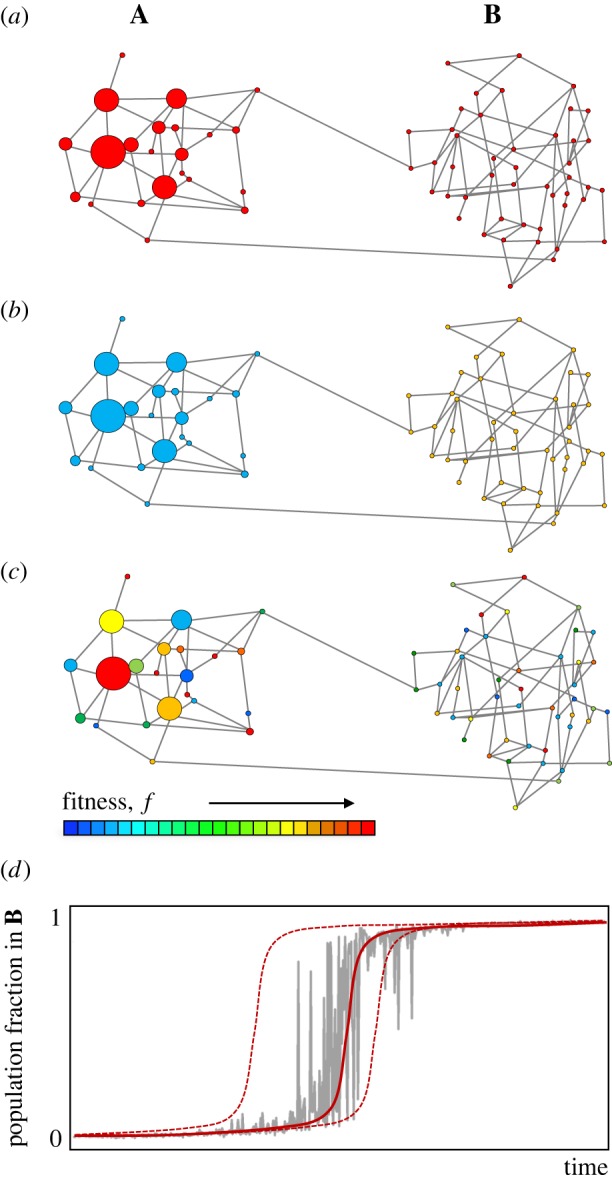
Genomic shifts result from the network-of-networks structure of the space of genotypes. Without loss of generality, we assume that λ1,A < λ1,B and the whole population is initially in network A. In (a–c), colours indicate the fitness of each node, as shown by the colour scale, and circle size is indicative of the number of individuals at each node. Though nodes in network B are represented with small circles, we assume they have no population initially. (a) Two weakly coupled regions of a unique NN. Differences in their eigenvalues only depend on differences in their topology. (b) Two different NNs with different fitness. The effect of fitness and topology can be separated, both affect their eigenvalues. (c) Two weakly connected regions in a fitness landscape. The effects of fitness and topology cannot be decoupled. (d) In all cases, the time of transitions is a stochastic variable, but the transition is fast once the mutational pathway is found (red curves, corresponding to different realizations of the process). In changing or noisy environments, the fitness value of each sequence might vary in time, so transitions are decorated by fluctuations (grey curve) whose strength grows as the tipping point is approached.